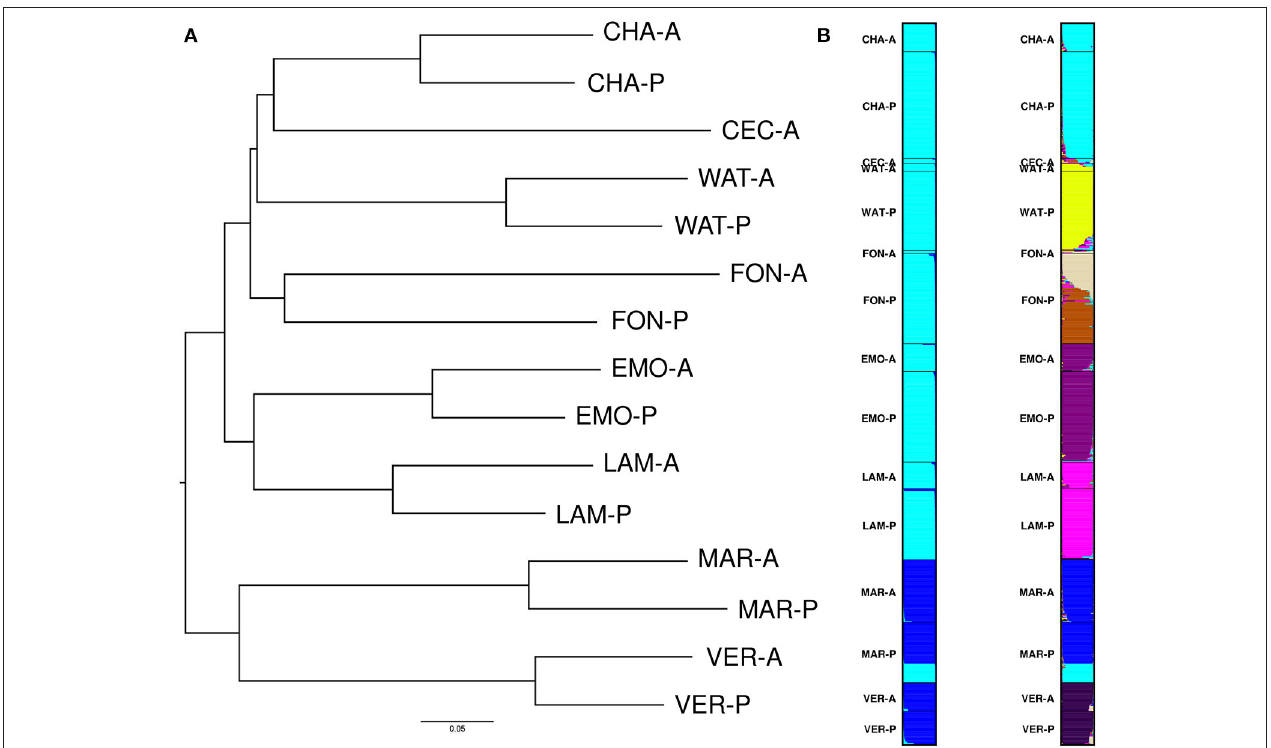
FIGURE 2 | (A) Neighbor-joining tree based on Cavalli-Sforza and Edwards’ genetic distances with the INA correction for null alleles and (B) results of Bayesian clustering (modal K = 2 and 8) for two generations (A, adults and P, seed progeny) in eight populations of Campanula glomerata . In the barplot, each individual is represented by a horizontal bar, showing the membership ( Q ) to each of the 2 or 8 modal